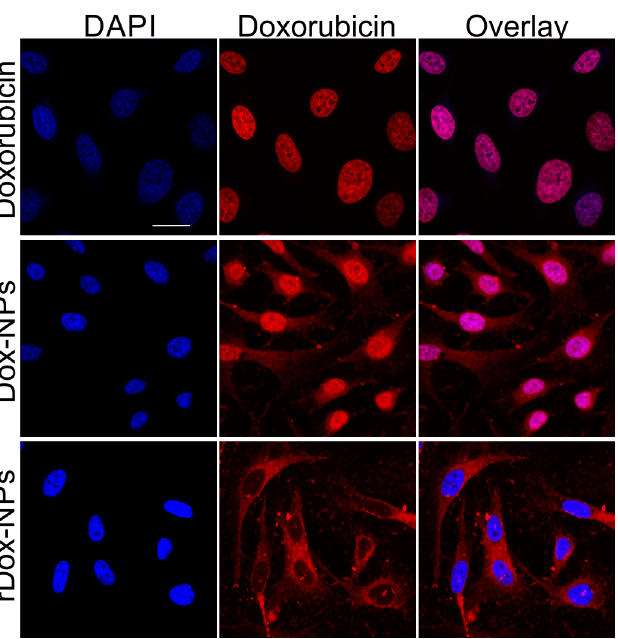
Fig 8. Dox-NPs release doxorubicin within cells. Photomicrographs of fixed HeLa cells incubated with free doxorubicin, Dox-NPs, and rDox-NPs. Cell nuclei were stained with DAPI (blue). Red color arises from natural fluorescence properties of doxorubicin. Scale bar = 20 μ